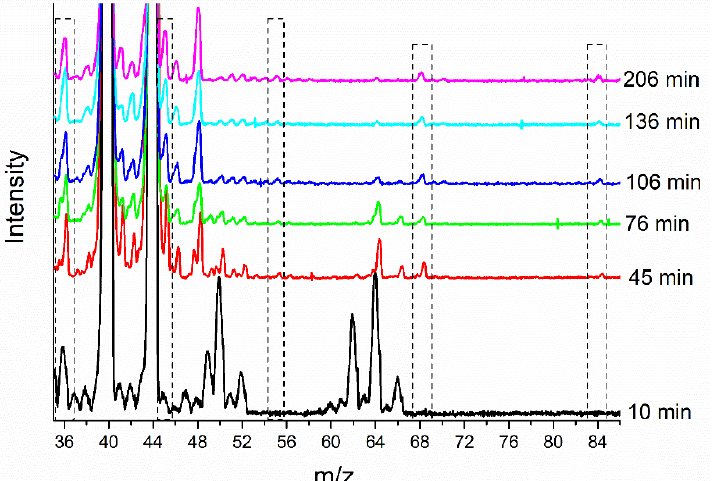
Figure 2. ( a ) Mass spectrum of the product of ethane oxidative dehydrogenation (ODH) over S-ACl, full-spectrum, and ( b ) details of low-intensity signals at m / z 45–70. At the bottom is dis- played the experimental mass spectrum, above that are the model spectra of the three most proba- ble chlorinated compounds formed during the reaction.